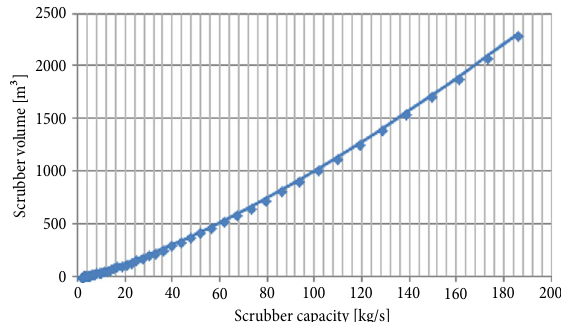
Fig. 3. Scrubber volume per scrubber